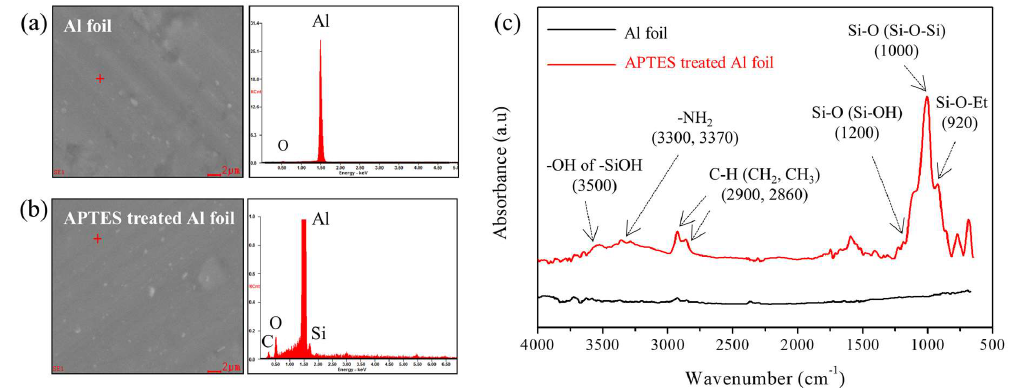
Figure 7. SEM images and EDX data of Al foil ( a ), APTES-treated Al foil ( b ) and FT-IR spectra of Al foil and APTES-treated Al foil ( c